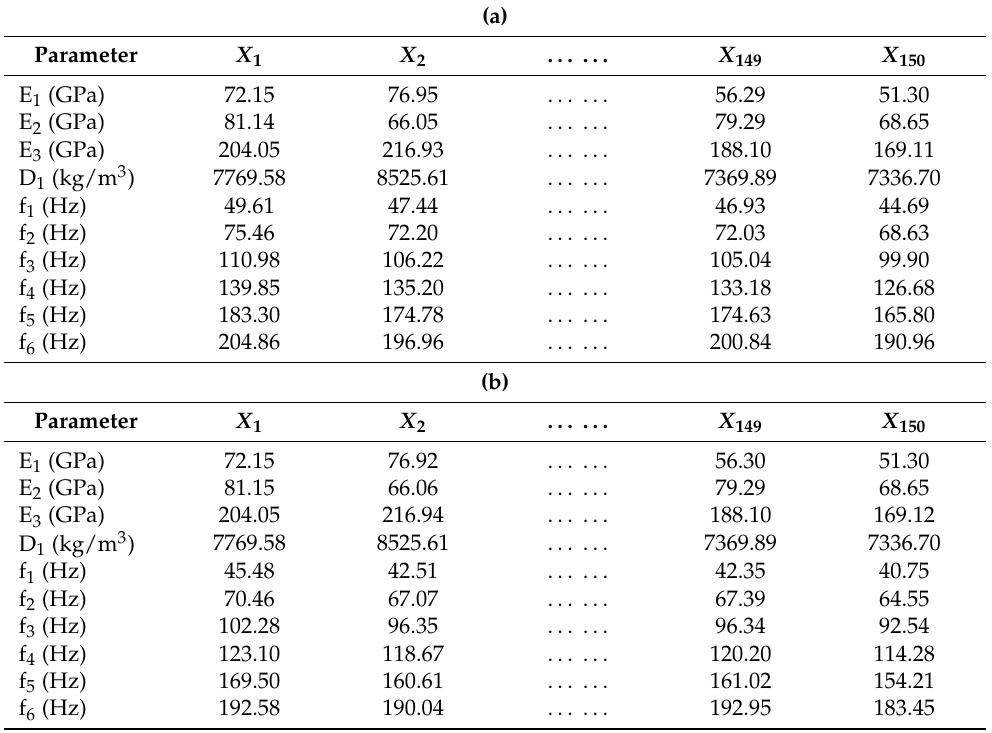
Table A1. ( a ). Design variable sampling points of solid FE model and corresponding first six natural frequencies. ( b ). Design variable sampling points of mixed model and corresponding first six natural frequencies.